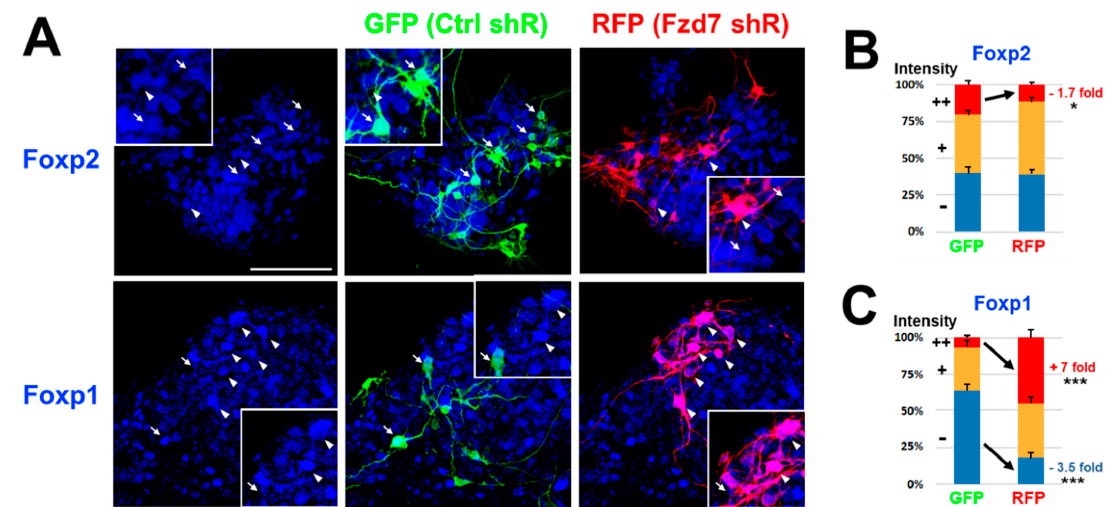
Figure 4. Foxp2 downregulation and Foxp1 upregulation with Fzd7 shRNA in primary neuronal cells. ( A ). IHC for GFP ( Ctrl shRNA cells: green) and RFP ( Fzd7 shRNA cells: red) with Foxp2 or Foxp1 immunostaining (blue) after four days in vitro (DIV) culture of primary neuronal cells in utero electroporated (IUE) at E13 ( n = 3 animals of each GFP and RFP). GFP (arrow) and RFP (arrowhead) cells showing strong (++) intensity of Foxp2 (lower panel: Foxp1) protein are respec- tively represented. Insert: higher magnification images of same area; scale bar: 100 µm. ( B , C ). Quantification of Foxp2 ( B ) or Foxp1 ( C ) signal with − , +, and ++ intensities which were compared/normalized to the intensity (+) observed in non-transfected cell as an intrinsic control of immunostaining quality ( n = 28–48 pictures counted with total 403–700 cells). Data (%) represent the mean and SEM of each intensity (total sum = 100%). Statistics: Student’s t-test; *: p < 0.05; ***: p < 0.005.